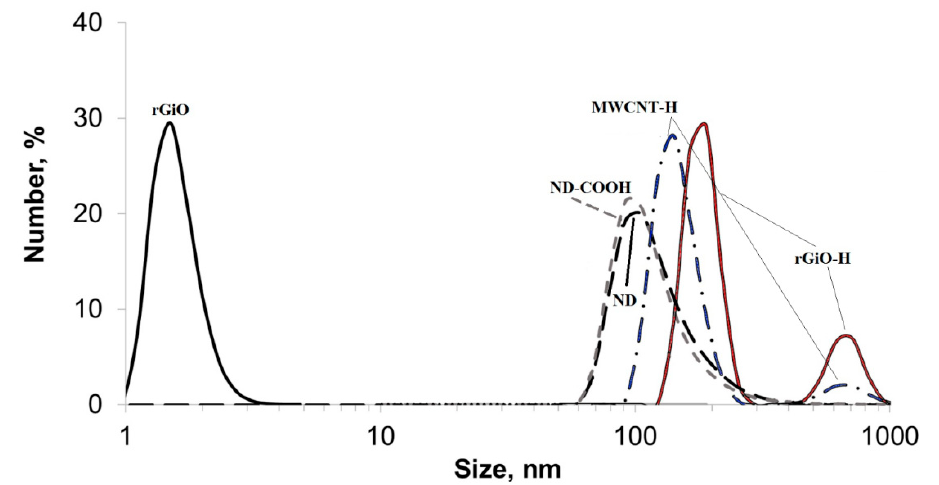
Figure A1. CNMs particle size distributions according to (DLS). Figure А 1. CNMs particle size distributions according to (DLS).